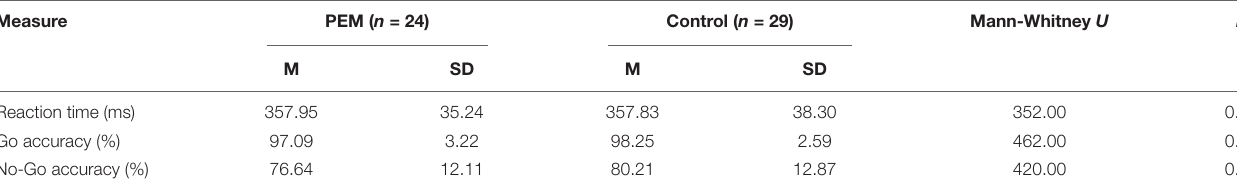
TABLE 2 | Means and standard deviations of behavioral measures for protein-energy malnutrition (PEM) and control groups. Measure PEM ( n =